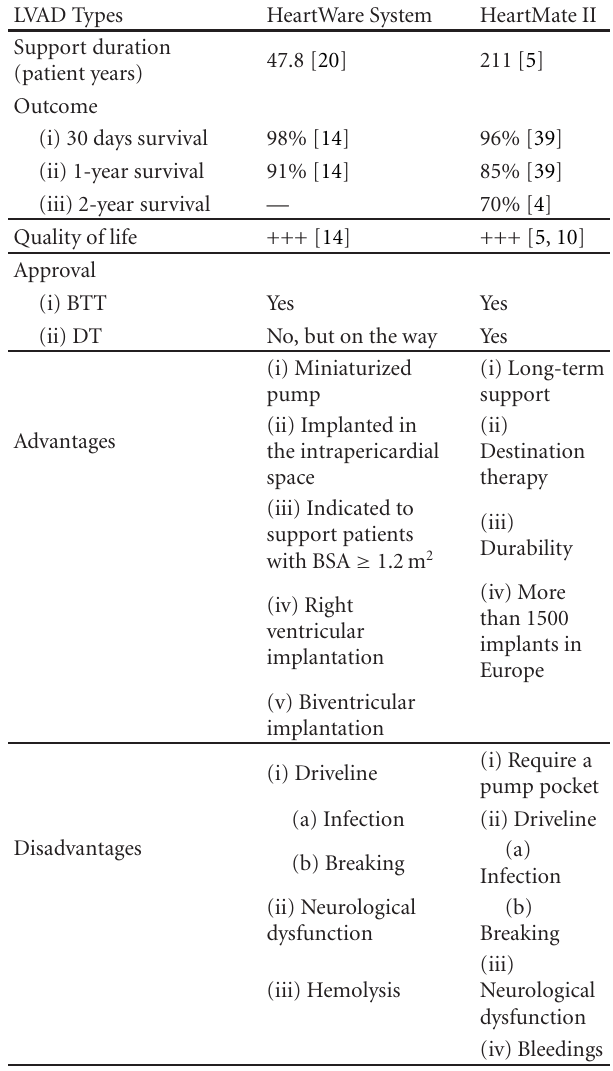
Table 3: Most commonly used